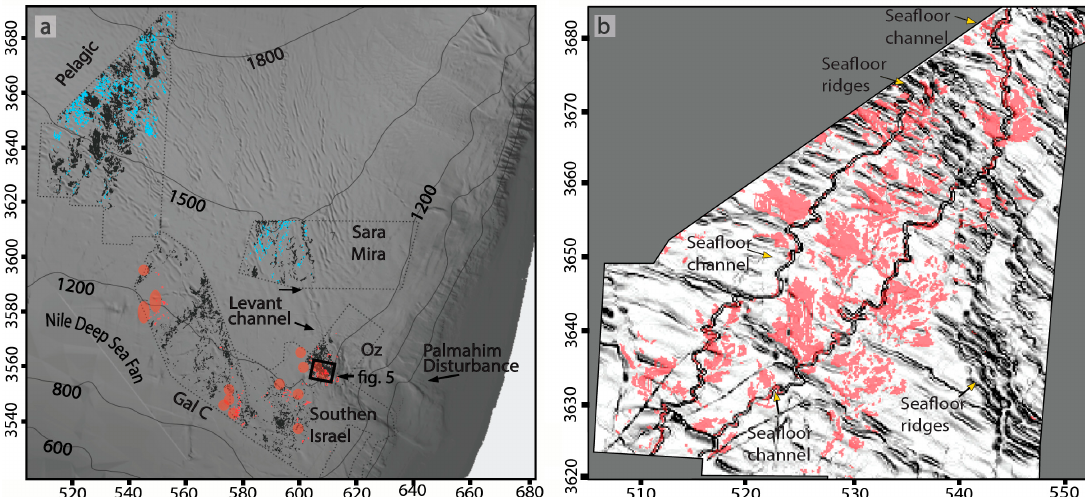
Figure 10. ( a ) A shaded relief map of the southeastern part of the Levant Basin bathymetric DEM [62,108] overlaid with the spatial distribution of the HASR automatic picks and pockmark clusters within the di ff erent 3D seismic blocks analyzed. Black dots mark the Shallow HASR, while blue dots mark the Deepening HASR. Red ellipses mark the location of pockmark clusters. This figure demonstrates the wide distribution of Shallow HASR picks across the Levant Basin; the concentration of pockmark clusters between water depths of 900 to 1300 m across the deep fan of the Nile; and the distribution of the Deepening HASR at water depths > 1300 m. ( b ) A zoom on the Pelagic 3D seismic block with the pronounced shading of the bathymetry (enhanced gray scale) overlaid with the automatic picks of the Shallow HASR (red). This figure demonstrates the relation between the Shallow HASR and seafloor channels of the Nile fan.